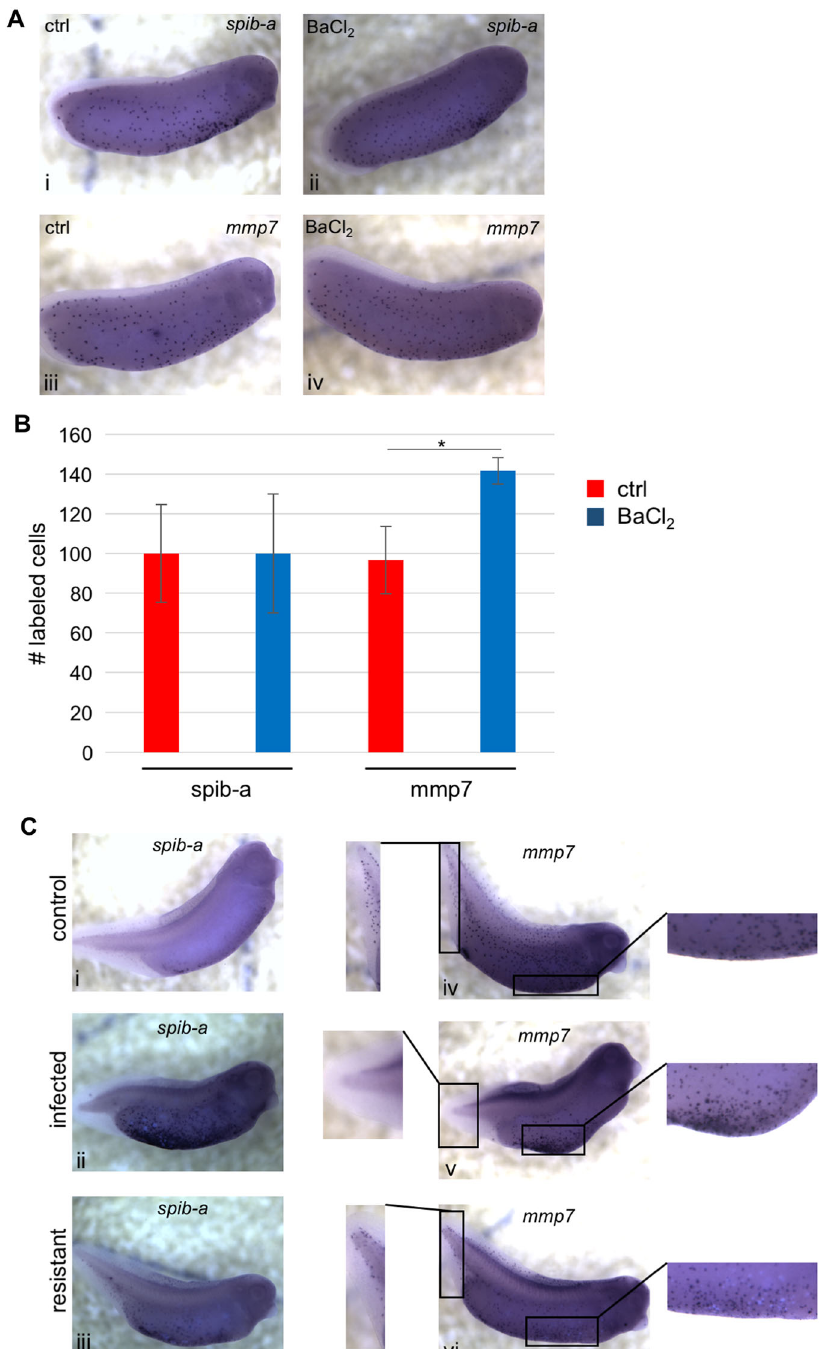
Fig. 5 Barium chloride-induced depolarization affects primitive myeloid cells distribution. a Visualization of spib-a and mmp7 expression by in situ hybridization at stage 26 in control (i, iii) and barium chloride-treated (ii, iv) conditions. b Quanti fi cation of spib-a and mmp7 -positive cells in control and barium chloride-treated conditions reveals that depolarization by barium chloride signi fi cantly increases the number of mmp7 -expressing cells at stage 26. Error bars represent the standard deviation from fi ve biological replicates. *denotes p < 0.05. c Visualization of spib-a and mmp7 expression by in situ hybridization at stage 33 in control (i, iv), infected (ii, v), and resistant (iii, vi)